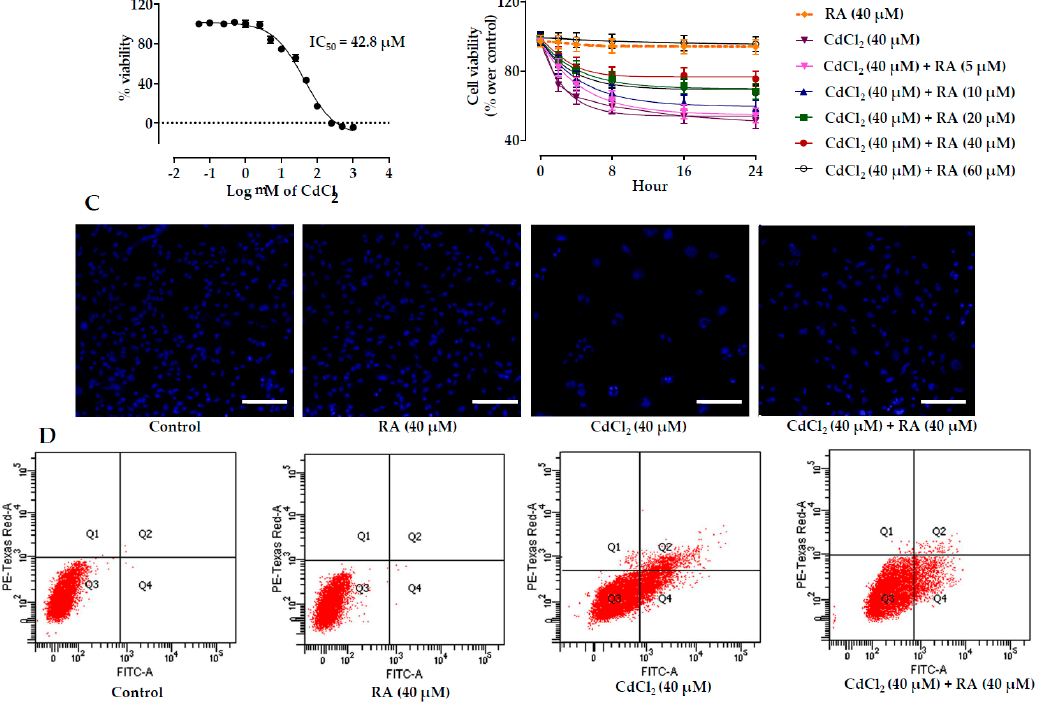
Figure 2. The effects on the cell viability, Hoechst nuclear staining, and flow cytometric analysis in the absence (CdCl 2 ) and in the presence of RA (CdCl 2 + RA) in vitro on isolated mouse proximal tubular epithelial cells. ( A ) Effect of CdCl 2 at different concentrations in the cell viability on murine proximal tubular epithelial cells. ( B ) Effect on the cell viability in the absence (CdCl 2 ) and presence of RA (CdCl 2 + RA) on murine renal tubular cells. ( C ) Effect on Hoechst staining in the absence (CdCl 2 ) and presence of RA (CdCl 2 + RA) on murine renal tubular cells. Scale = 20 μ m. ( D ) Percentage of apoptotic and necrotic cells in the absence (CdCl 2 ) and presence of RA (CdCl 2 + RA) on murine renal tubular cells analyzed by flow cytometric assay. Data are represented as means ± SD, n = 3 (number of plates).